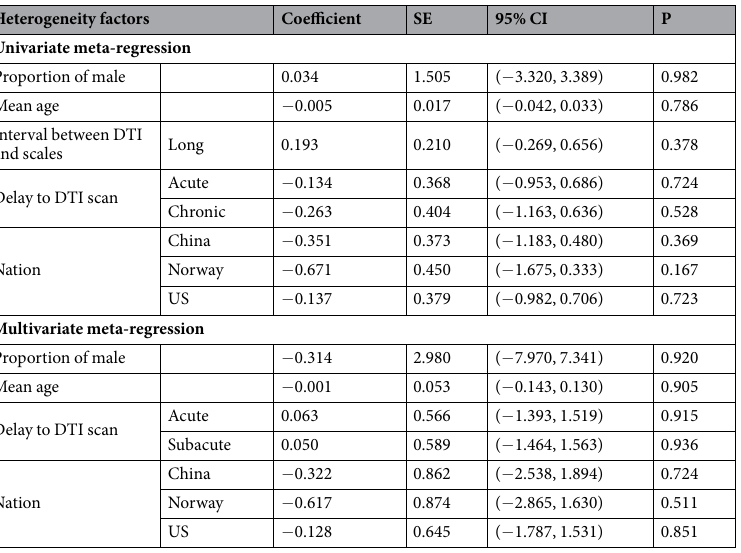
Table 1. Summary of meta-regression analyses for the potential source of heterogeneity. SE, standard error; CI, confidence interval.